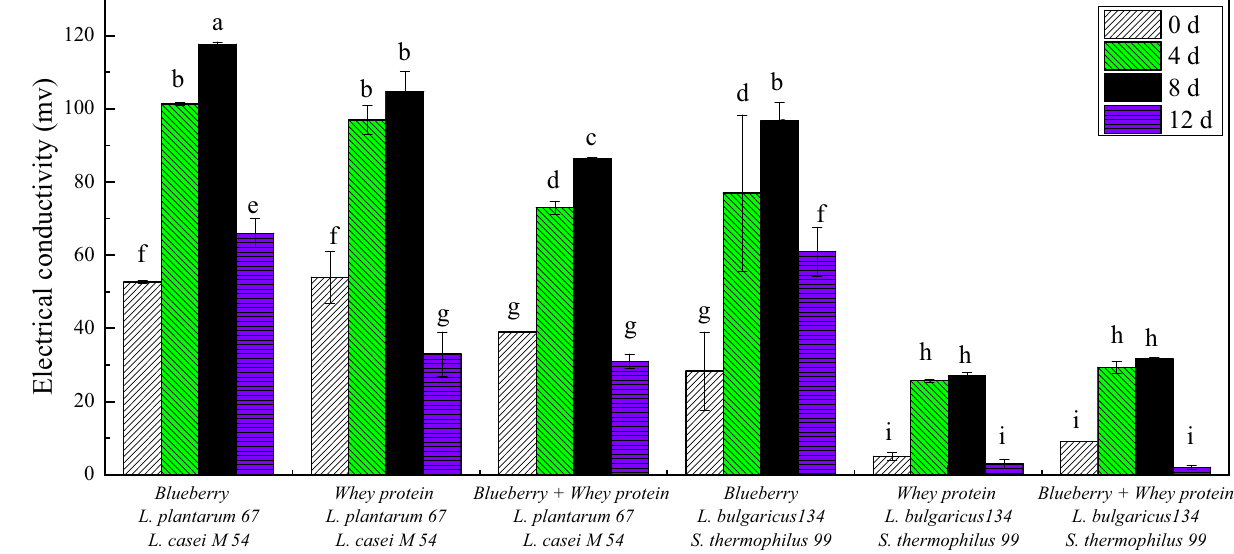
Figure 4. The electrical conductivity of E. coli cultures treated with whey protein and blueberry juice mixture system fermented with Lactobacillus.